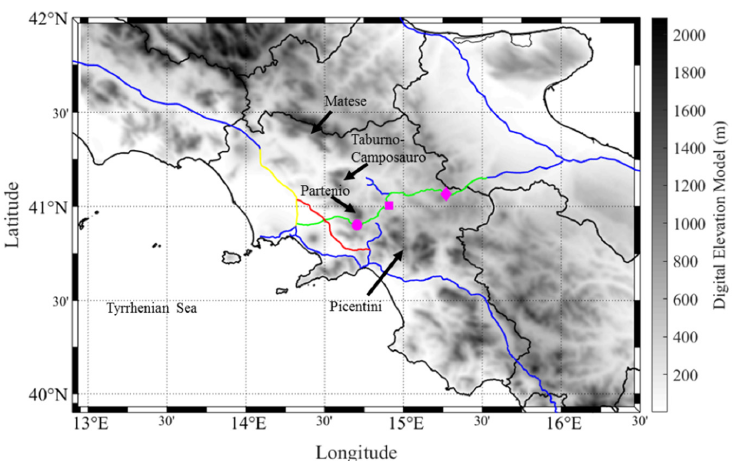
Figure 1. Map of study area, including the motorways of interest for the CARMEN project, i.e., the A1 highway (from Caianello to Naples), the A16 highway (from Naples to Candela) and the A30 highway (from Caserta to Mercato San Severino). The three road sections are shown as yellow, green and red lines, respectively. The magenta markers indicate the three passes located along the A16 highway, i.e., Monteforte Irpino (619 m asl, filled-in circle), Montemiletto (502 m asl, filled-in square) and Scampitella (670 m asl, filled-in diamond). The black arrows indicate the main orographic features of the study area (Matese, Taburno-Camposauro, Partenio and Picentini). The highways not involved in the CARMEN project are marked as blue lines.